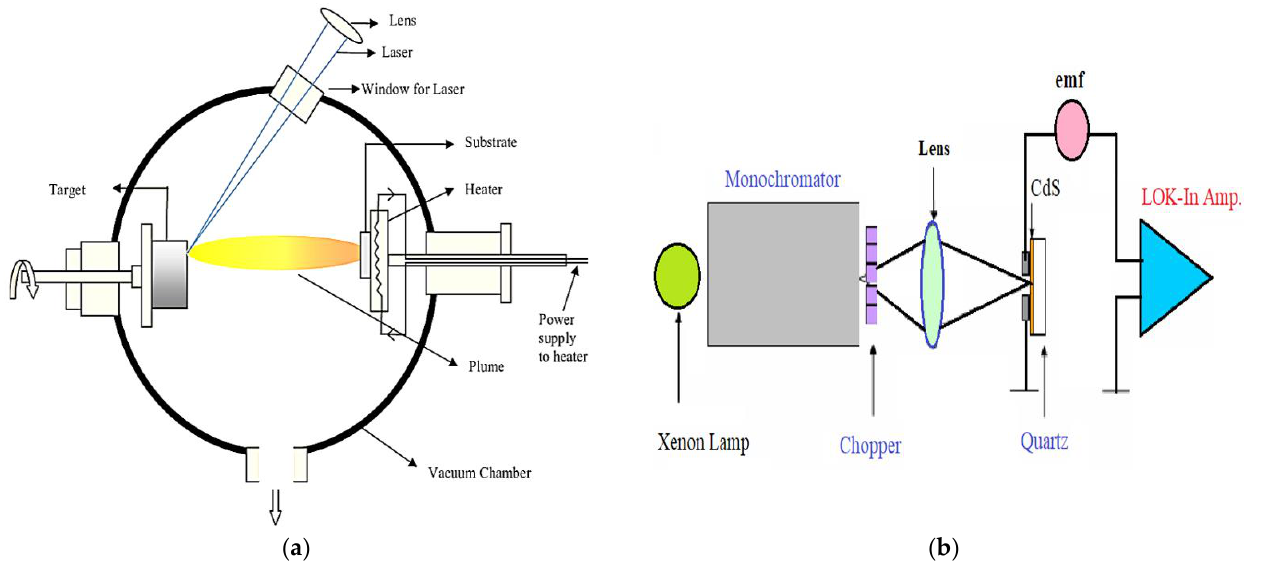
Figure 1. ( a ) The schematic diagram of pulsed laser deposition system. ( b ) Experimental setup for AC Photocurrent.